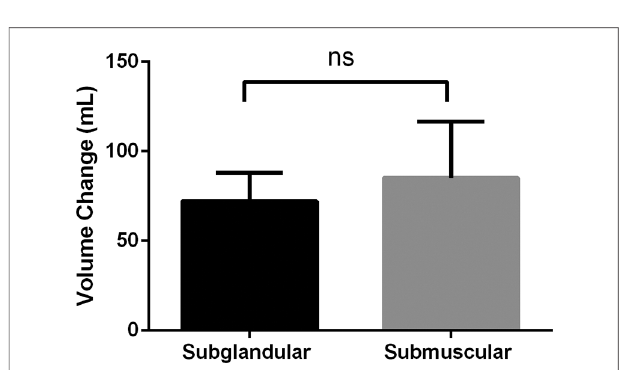
FIGURE 3 | The mean retention rate of the fat graft in the retromammary group after 6 months was 35.87%±6.60, and 41.28%±7.64 in the retropectoral group. No signi fi cant difference was observed between these two groups ( p =0.1076).